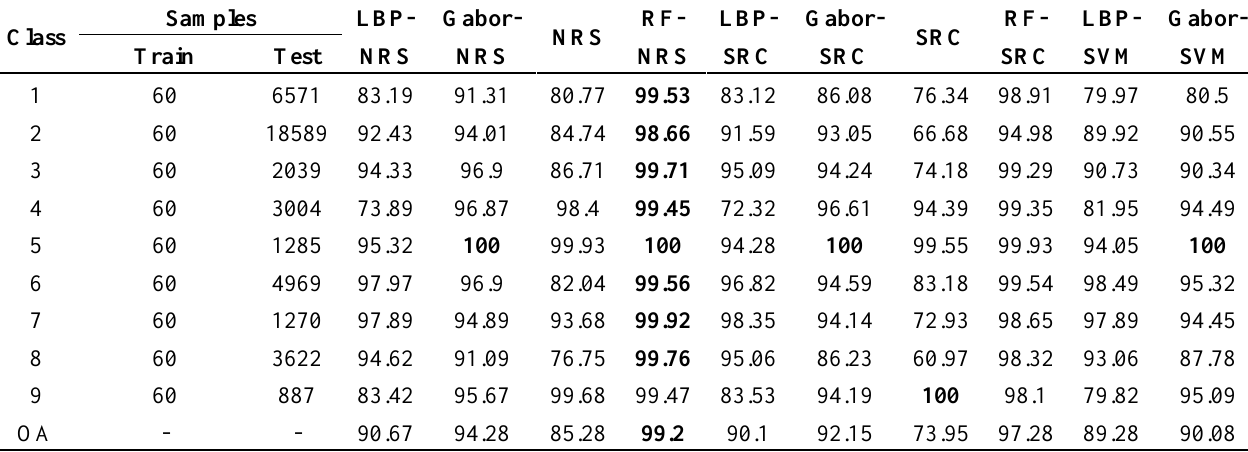
Table 8. Classification accuracy (%) for the University of Pavia